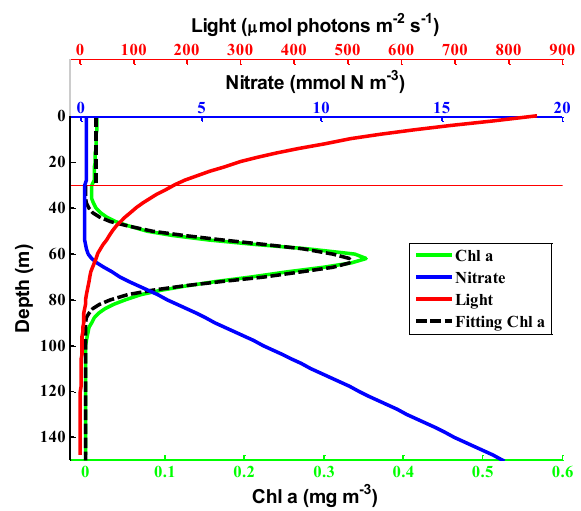
Figure 3. Steady-state vertical distributions of chlorophyll, nitrate Fig. 3 Steady-state vertical distributions of chlorophyll, nitrate, and light determined by numerical and light determined by numerical solutions of Eqs. (1) and (2). solutions of Eqs. (1) and (2). Horizontal red dash-dotted line indicates the depth of the surface Horizontal red line indicates the depth of the surface mixed layer. mixed layer. Black dash line represents the fitting curve of vertical chl a profile. The fitting Black dash line represents the fitting curve of vertical Chl a profile. equation The fitting equation is